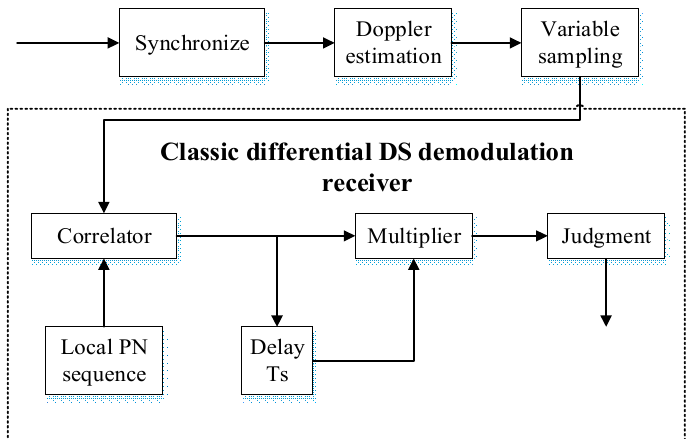
Figure 4. Illustration of the demodulation processing of the receiver.